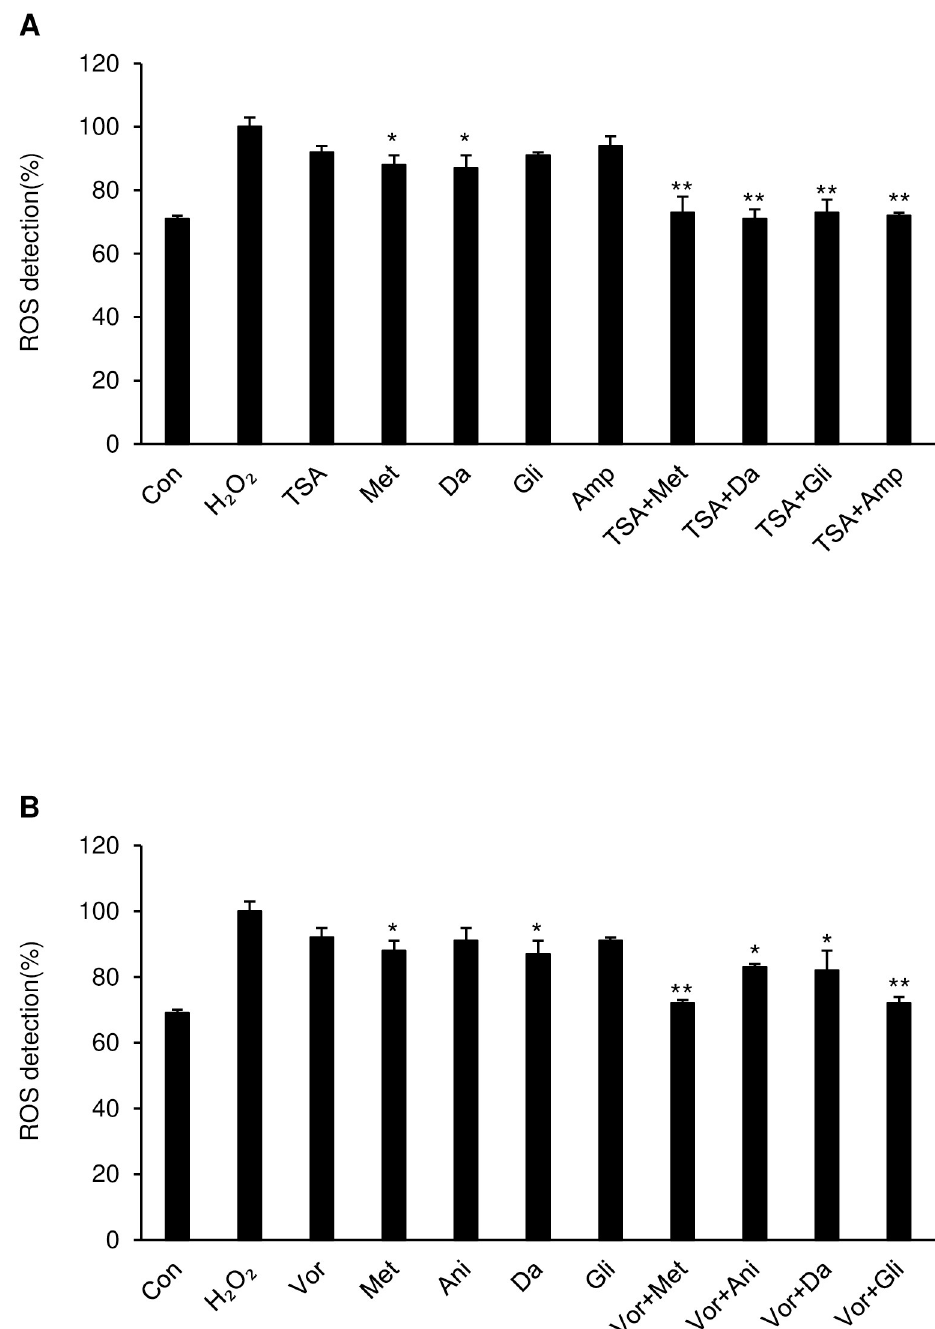
Fig 4. Removal activity of cellular ROS concentration was detected as an anti-aging effect. ROS detection measured by fluorescence intensity using a microplate reader. Hydrogen peroxide (H 2 O 2 ) was administered to induce ROS-based senescence, then single drugs or combinatorial drug pairs were administered to HL-60 cells to protect against ROS-induced aging. (A) HL-60 cells were exposed to H 2 O 2 (10 μ M) for 24 h and then treated with trichostatin A, metformin, danazol, glibenclamide, ampyrone, and each prior drug was co-treated with trichostatin A. or (B) with vorinostat, metformin, anisomycin, danazol, glibenclamide and each prior drug with vorinostat for 36 h. The intracellular ROS levels were detected with a microplate reader capable of measuring Ex/Em 495/529 nm spectra and recorded. � p < .05, �� p < .01 vs H 2 O 2 group.